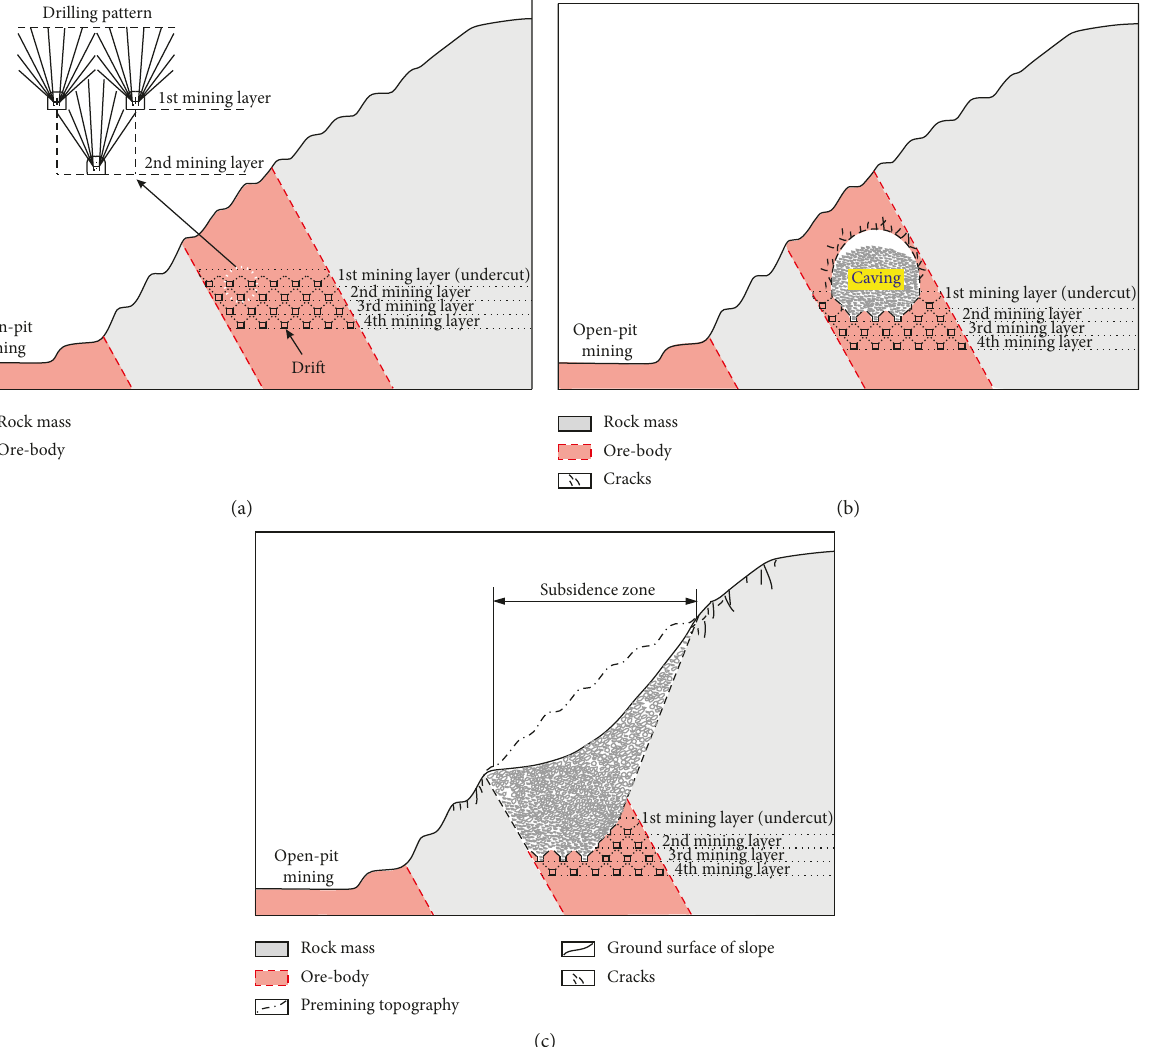
Figure 4: Illustration of mining scheme for hanging-wall ore-body via the induced caving mining method. (a) Mine layout. (b) Caving after undercutting. (c) Slope failure due to